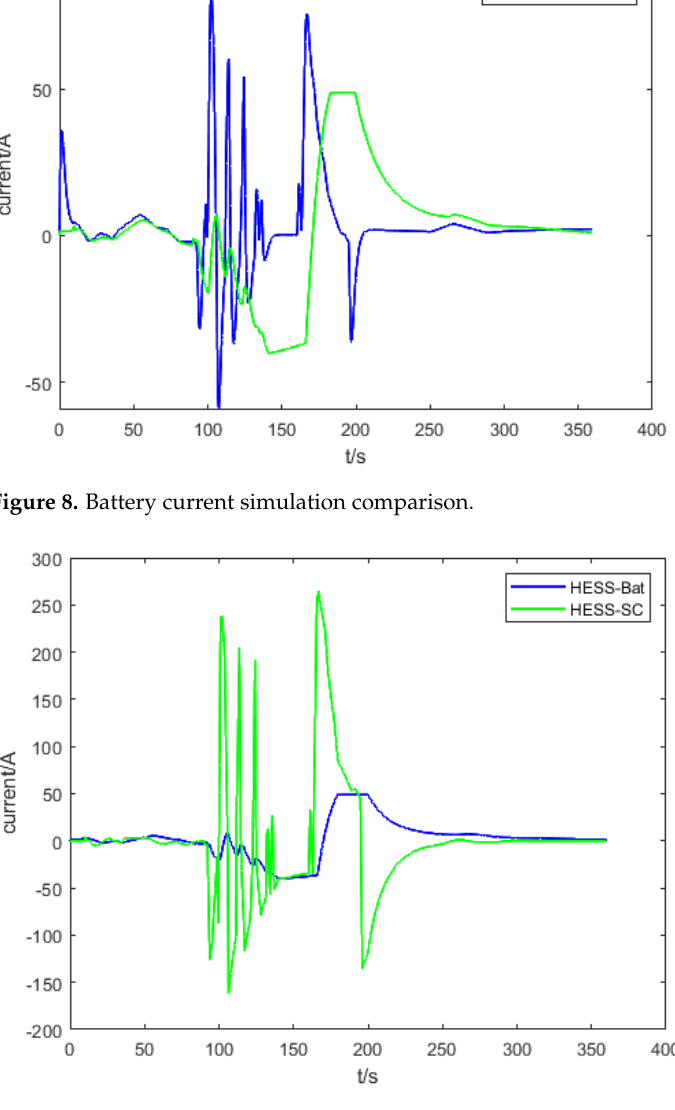
Figure 9. Output current simulation curves of battery and supercapacitor.